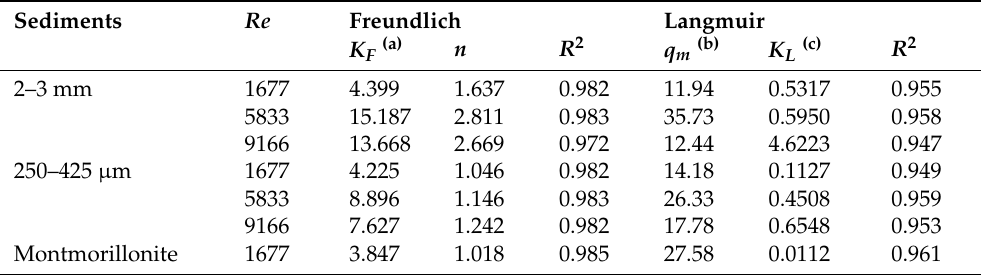
Table 4. Freundlich and Langmuir adsorption parameters of SDZ adsorption on different sediments.